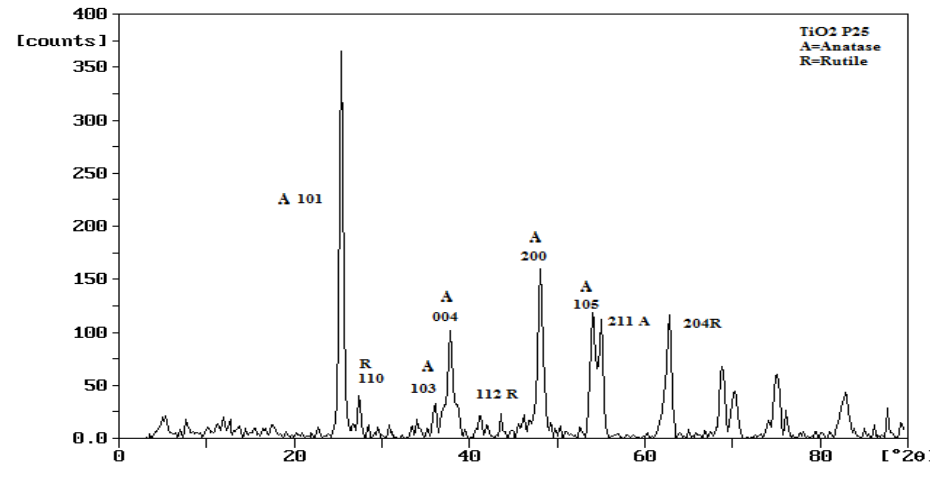
Figure 1. XRD pattern of Degussa P25 catalyst